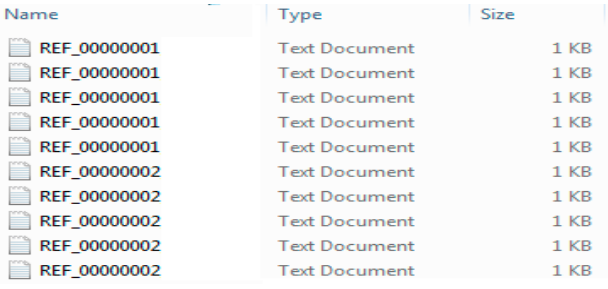
Figure 9. Reference data files for RP 1 and RP 2 collected during the experiment.